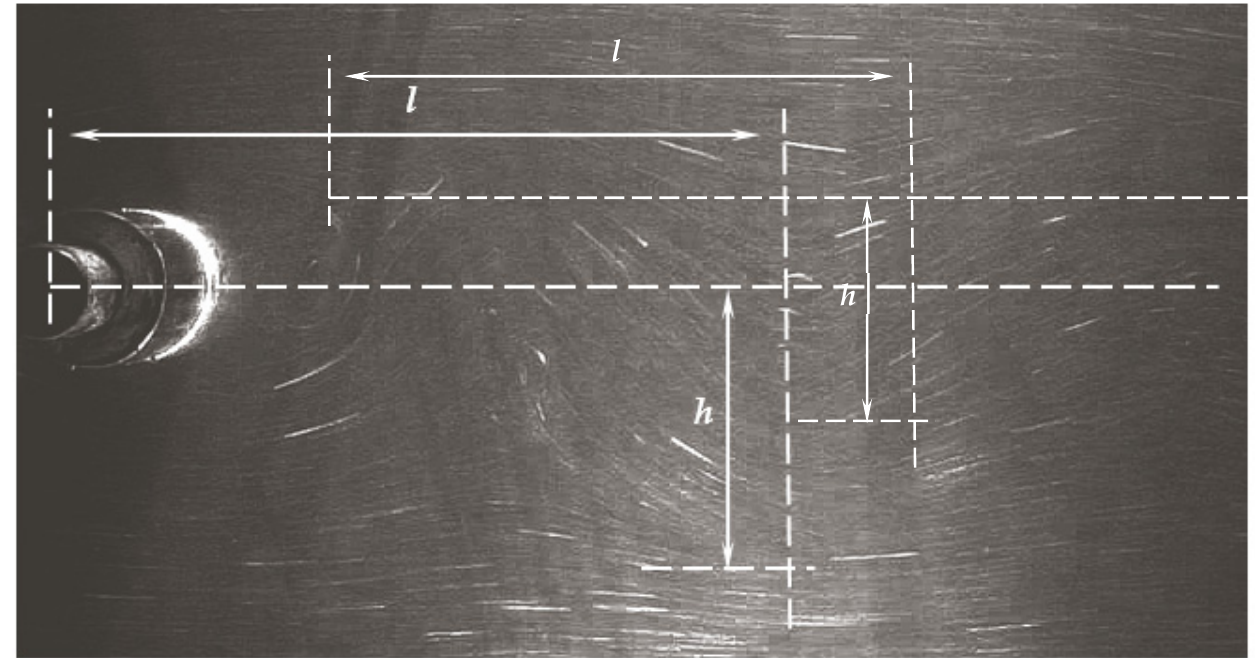
Figure 19. Schematic of geometry of von Karman vortex street.